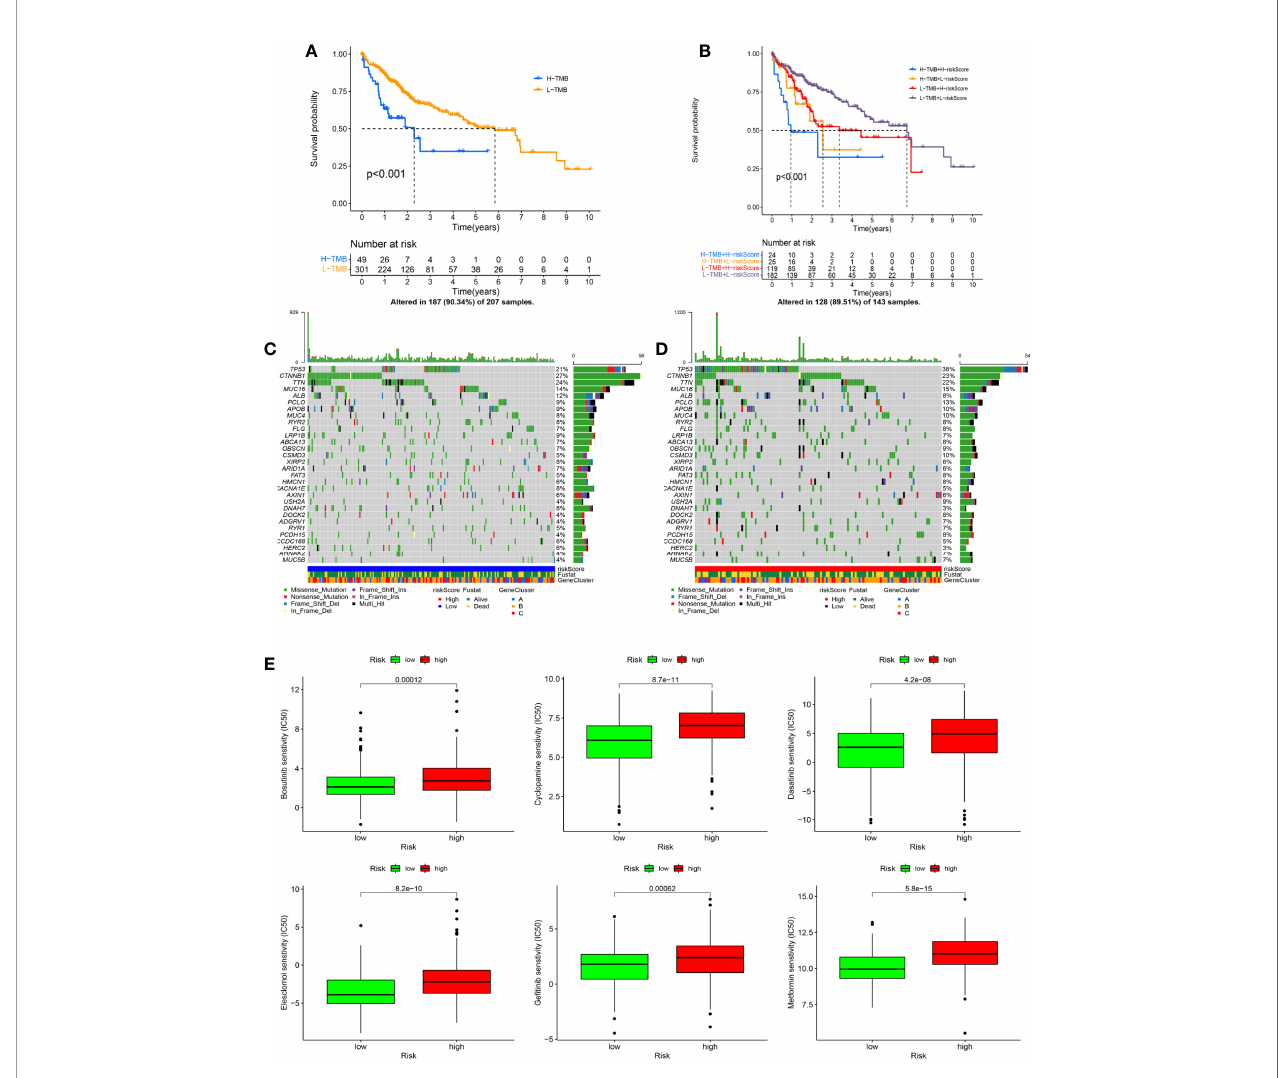
FIGURE 8 | The exchange of risk score is closely related to tumor mutational burden (TMB) and drug sensitivity. (A) The Kaplan – Meier (K-M) survival curve shows the difference in overall survival (OS) in the different TMB groups. (B) The K-M survival curve displays the combined impact of TMB and risk score on the OS. (C, D) The oncoplots indicate the differences in TMB status (including mutation type, number of mutations, and mutated genes) between risk scoring groups. (E) The drug sensitivity analysis shows the correlation between risk score and chemotherapeutic drugs (including bosutinib, cyclopamine, dasatinib, ge fi tinib, metformin, and